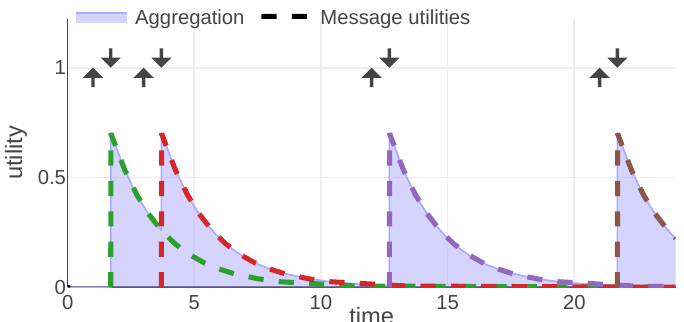
Figure 5. A status (cid:48) and U status (cid:48) functions plotted for a mission example. c (cid:13) 2019 IEEE. Reprinted, with permission, from